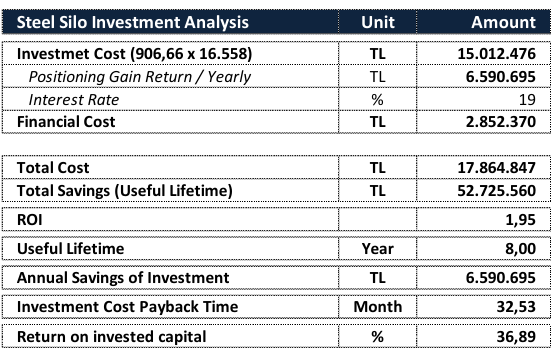
Table 11. Return on investment